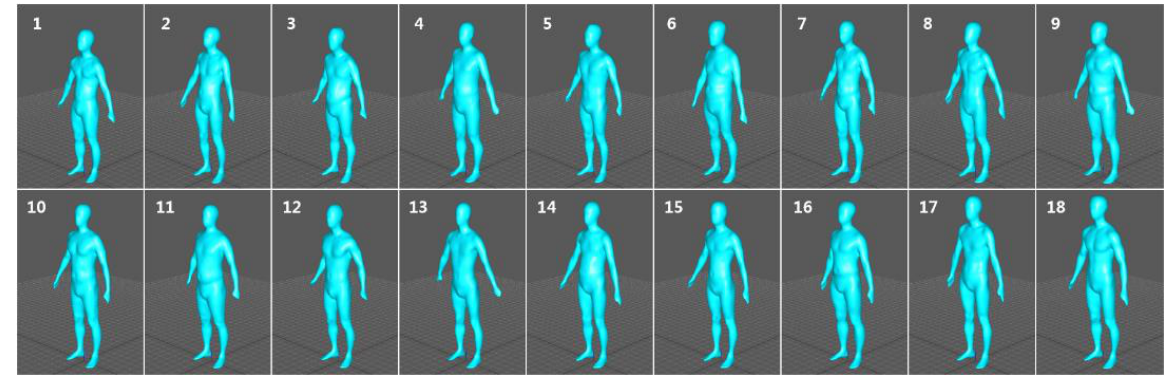
Figure 7. Results of average human body model generation by section.